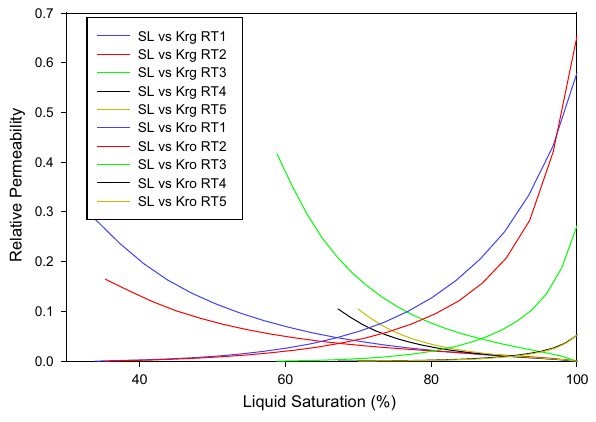
Fig. 10 Relative permeability curves in gas–oil system